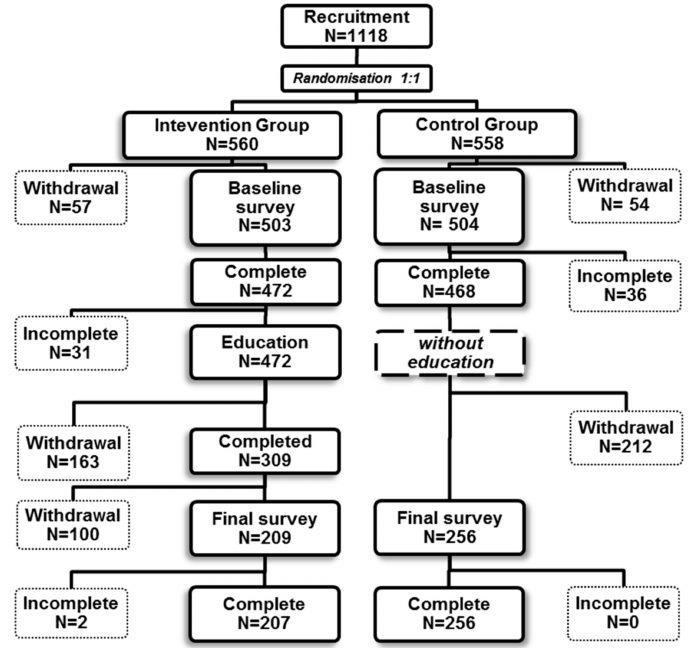
Figure 1. Summary of the number of participants in each study phase (including dropouts).